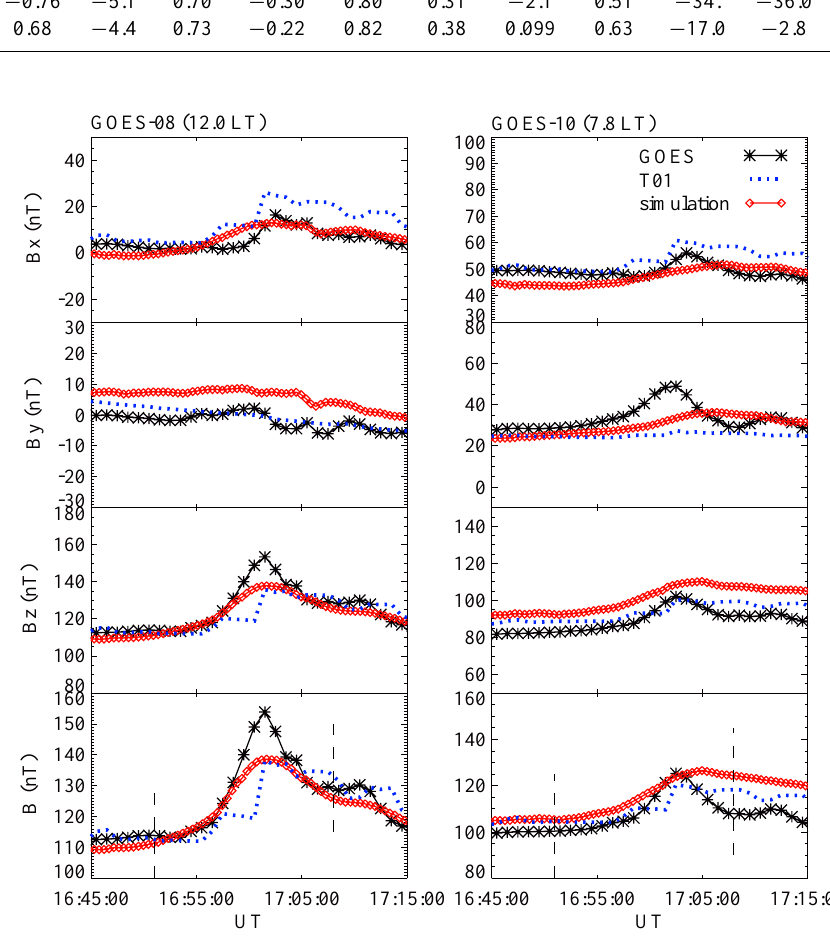
Fig. 4. Magnetic field at GOES-08 (left) and -10 (right) for the 6 June 2000 event. Figure formats are similar to Fig. 2.